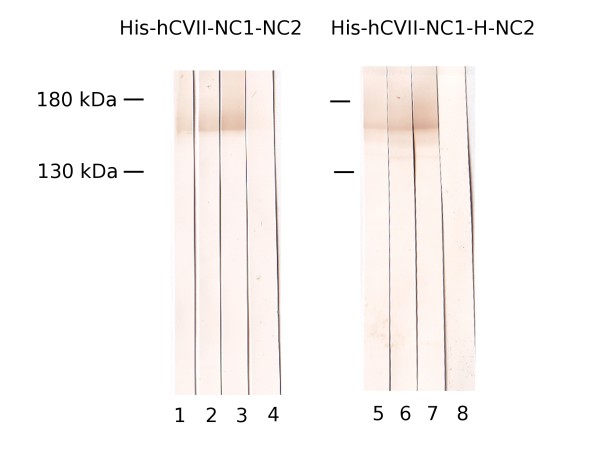
Immunoreactivity of epidermolysis bullosa acquisita (EBA) autoantibodies with the recombinant forms of collagen VII. Purified, recombinant His-hCVII-NC1-NC2 (lanes 1-4) and His-hCVII-NC1-H-NC2 (lanes 5-8) were electrophoretically separated by 8% SDS-PAGE, transferred to nitrocellulose and immunoblotted with EBA patient's sera (lanes 1-3 and 5-7) and normal human sera (NHS) (lanes 4 and 8).